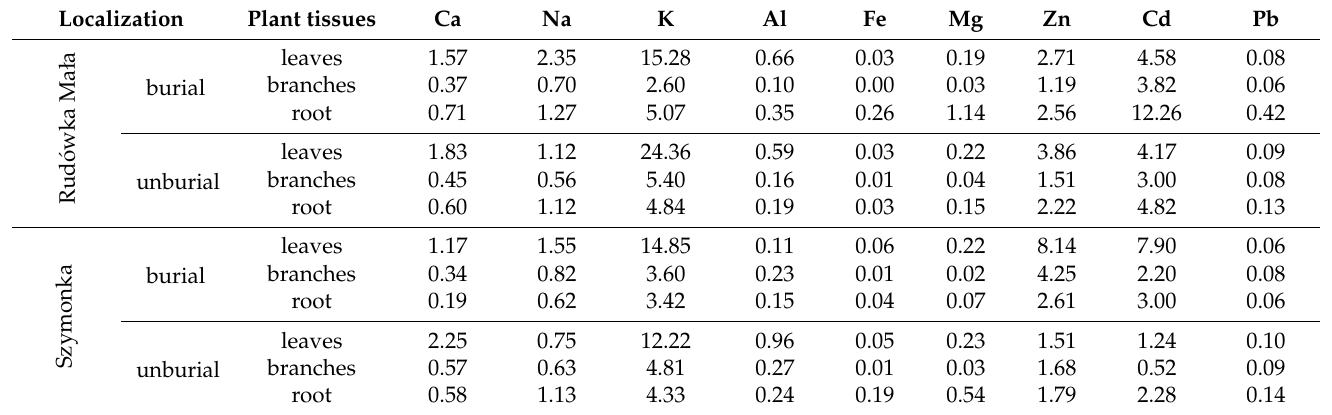
Table 9. Bioaccumulation factor (BAF) values for selected element in S. vulgaris .